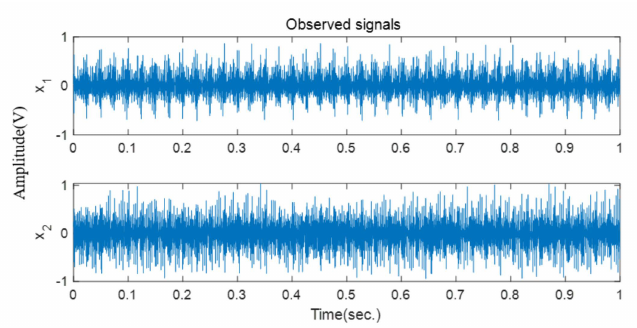
Figure 12. Waveform of the two collected vibration signals in the time domain.